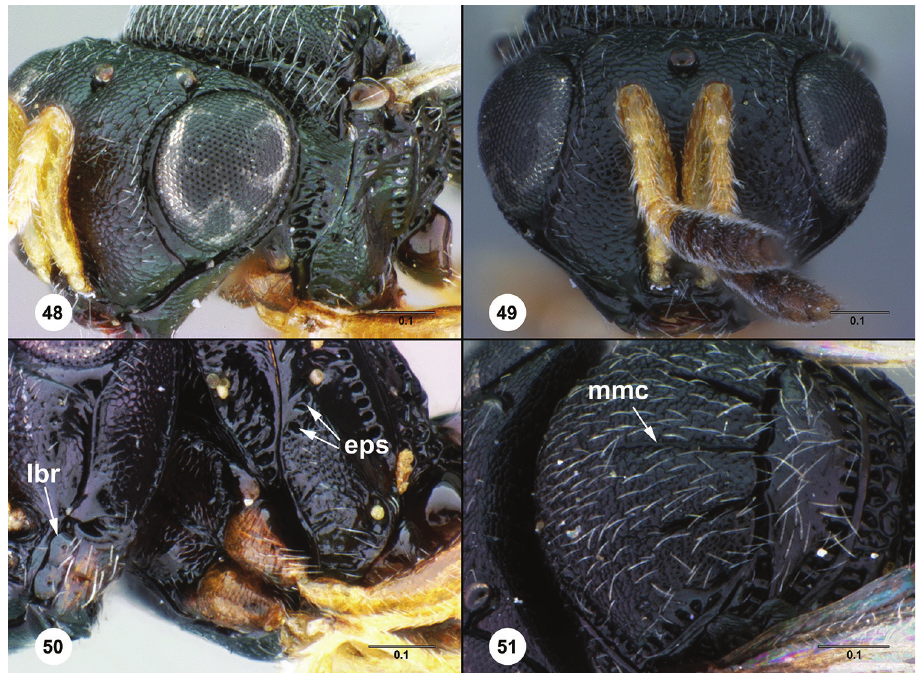
Figures 48–51. Trissolcus edessae , female (USNMENT00916178) 48 head and mesosoma, anterolateral view 49 head, anterior view 50 head and mesosoma, ventrolateral view 51 mesosoma, dorsal view. Scale bars in